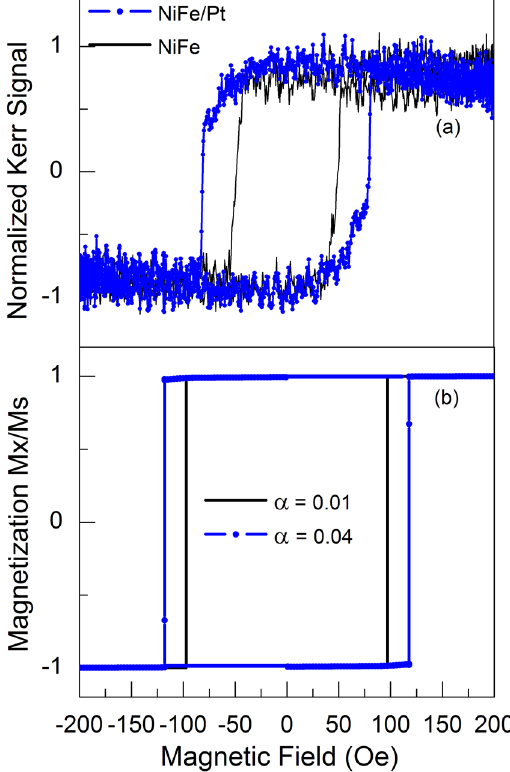
Figure 3. Examples of axial magnetic hysteresis behaviour for nanowires (triangular modulated edges with 75 nm amplitude). ( a ) Measured hysteresis for Py (10 nm) (continuous line) and Py(10 nm)/Pt(0.6 m) nanowires (dots). The reversal field is observed to be higher for Py(10 nm)/Pt(0.6 m) than Py(10 nm). ( b ) Simulated magnetic hysteresis for nanowires with a damping parameter of 0.01 (continuous line) and 0.04 (dots) show that increased damping provided by Pt overlayer enlarges the reversal field for larger